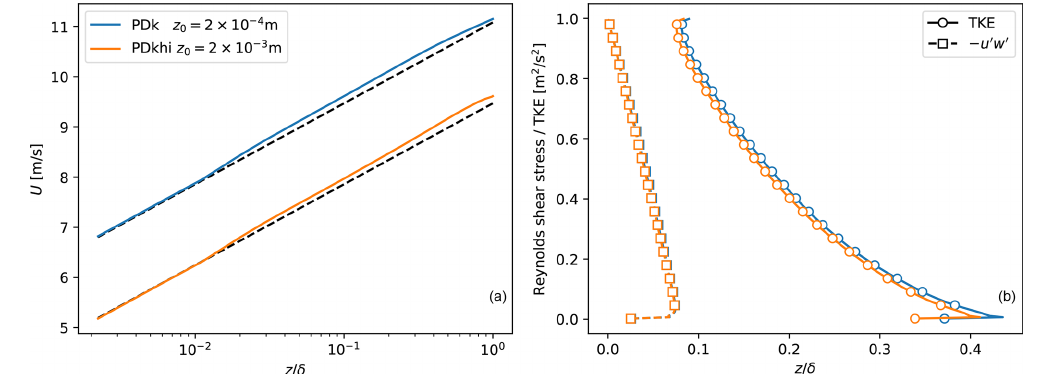
Figure 6. Flow profiles for PDBL cases. (a) Mean velocity. Dashed lines indicate log-law profiles. (b) Resolved Reynolds shear stress and turbulent kinetic energy. Markers are plotted every 10 data points for clarity.